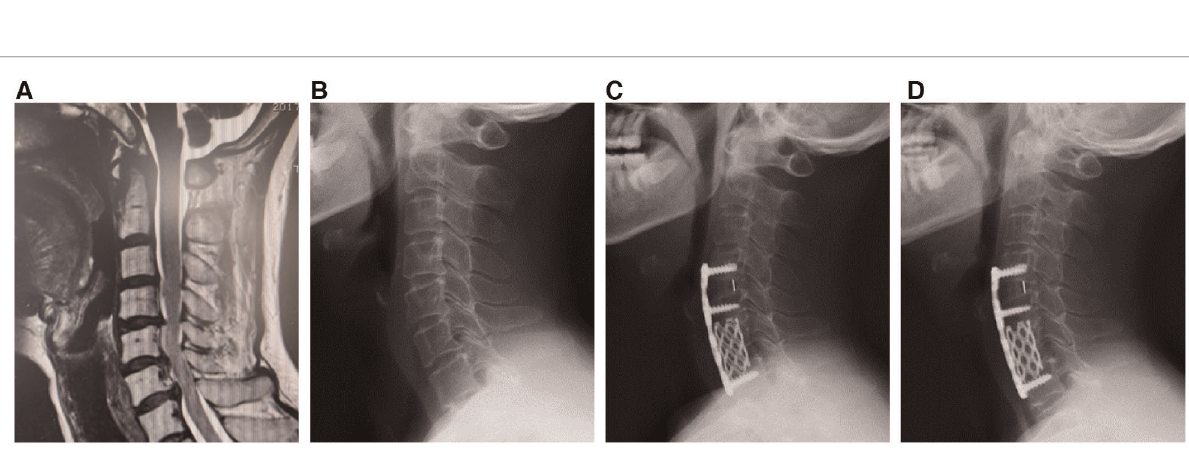
FIGURE 2 Female, 50-year-old, underwent one-level anterior cervical discectomy and fusion (ACDF) and one-level anterior cervical corpectomy and fusion (ACCF) surgery. ( A ) The pre-operational MRI, ( B ) the x-ray of pre-operation, ( C ) operation after 3 months, and ( D ) the fi nal